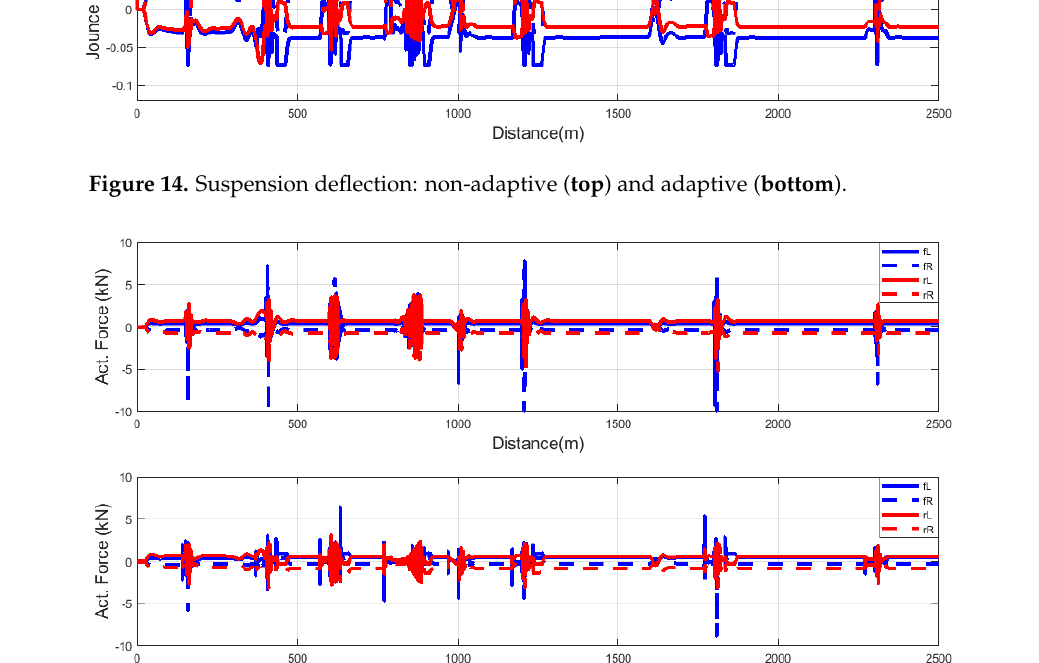
Figure 15. Control forces: non-adaptive ( top ) and adaptive ( bottom